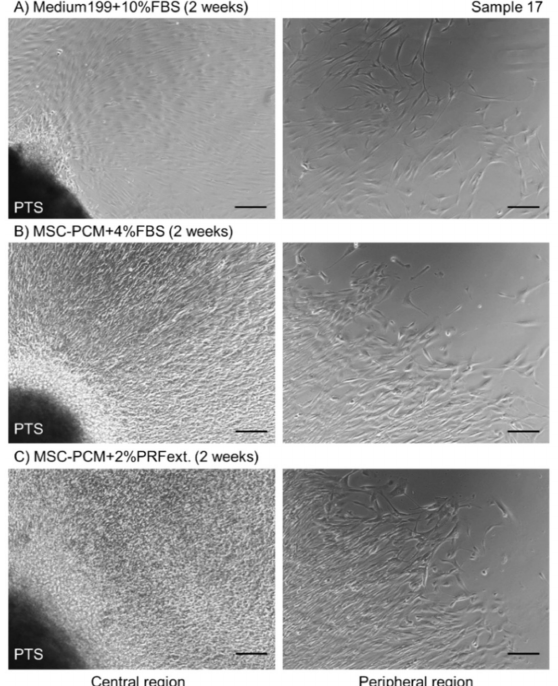
Figure 2. Photomicrographs of periosteal cells in the central and peripheral regions of periosteal sheets cultured in different culture media. ( A ) Medium199 + 10% fetal bovine serum (FBS), ( B ) MSC-PCM + 4% FBS, ( C ) MSC-PCN + 2% platelet-rich fibrin extract (PRFext). Bar = 50 µ m. PTS: periosteum tissue